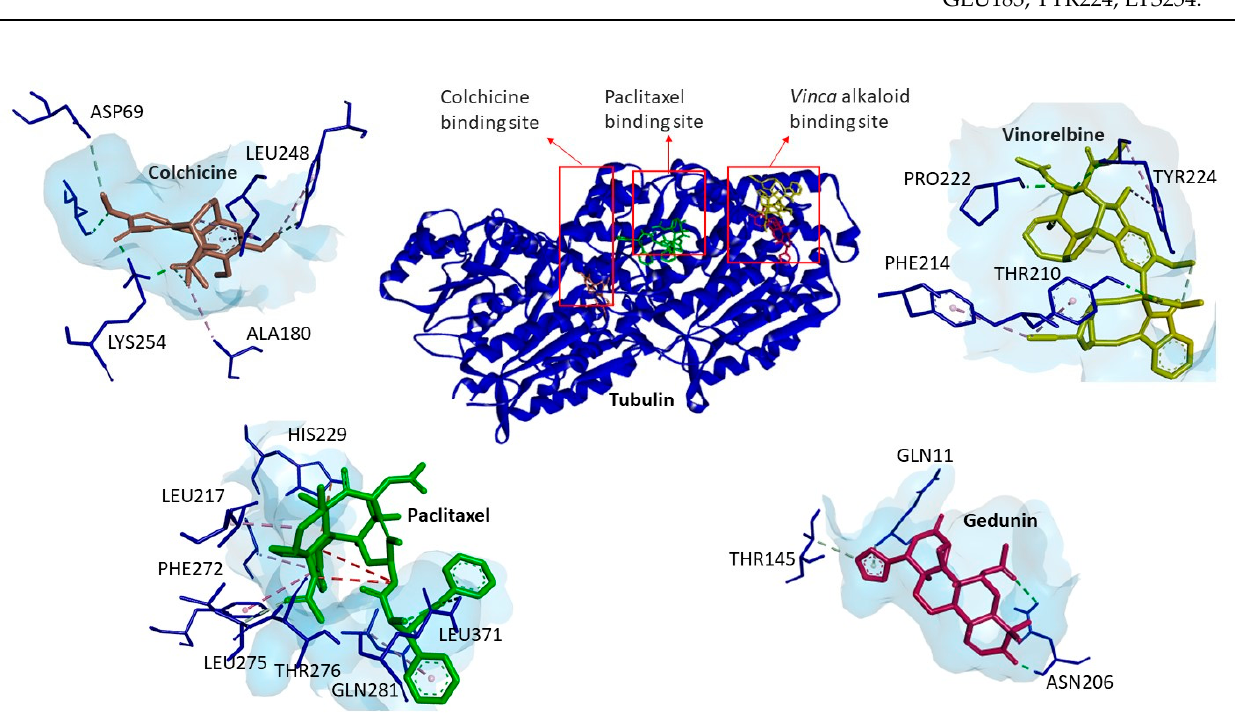
Figure 7. Molecular docking of gedunin to human α - and β -microtubules using AutoDock4.2.6. Gedunin was preferentially bound to the Vinca alkaloid binding site but not to the taxane or colchicine binding sites. Table 3. Molecular docking of gedunin to three different drug-binding sites of β -tubulin. Shown are the lowest binding energies (kcal/mol), predicted inhibition constants (µM), and amino acids in- volved in the ligand interaction of gedunin in comparison to the control drugs vinorelbine, paclitaxel, and colchicine, which are known to bind to the three binding sites.